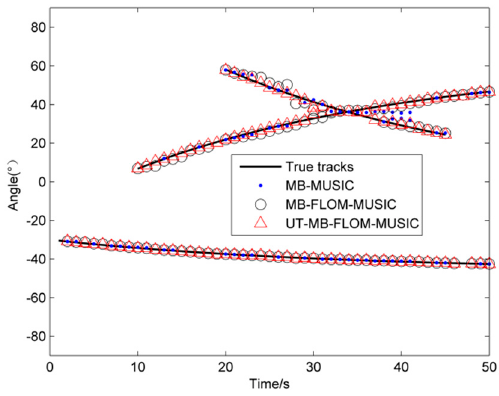
Figure 8. Target trajectory, α = 1.3, L = 100, and GSNR = 10 dB.